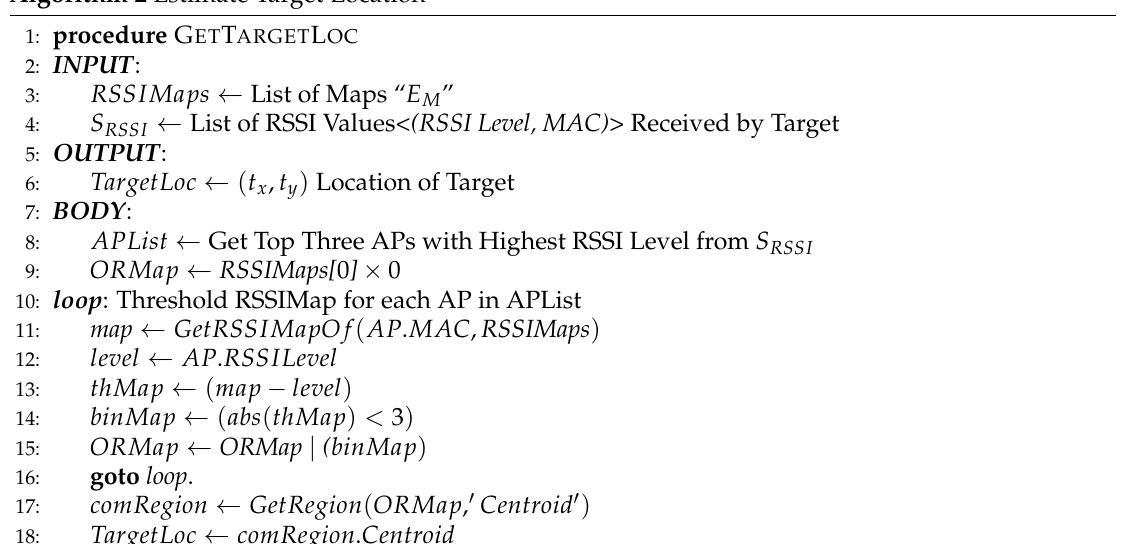
Algorithm 2 Estimate Target